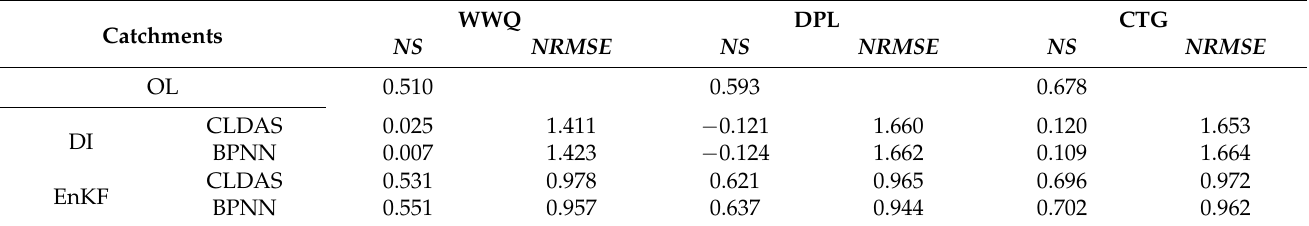
Table 3. Results of the two methods SM DA for the three